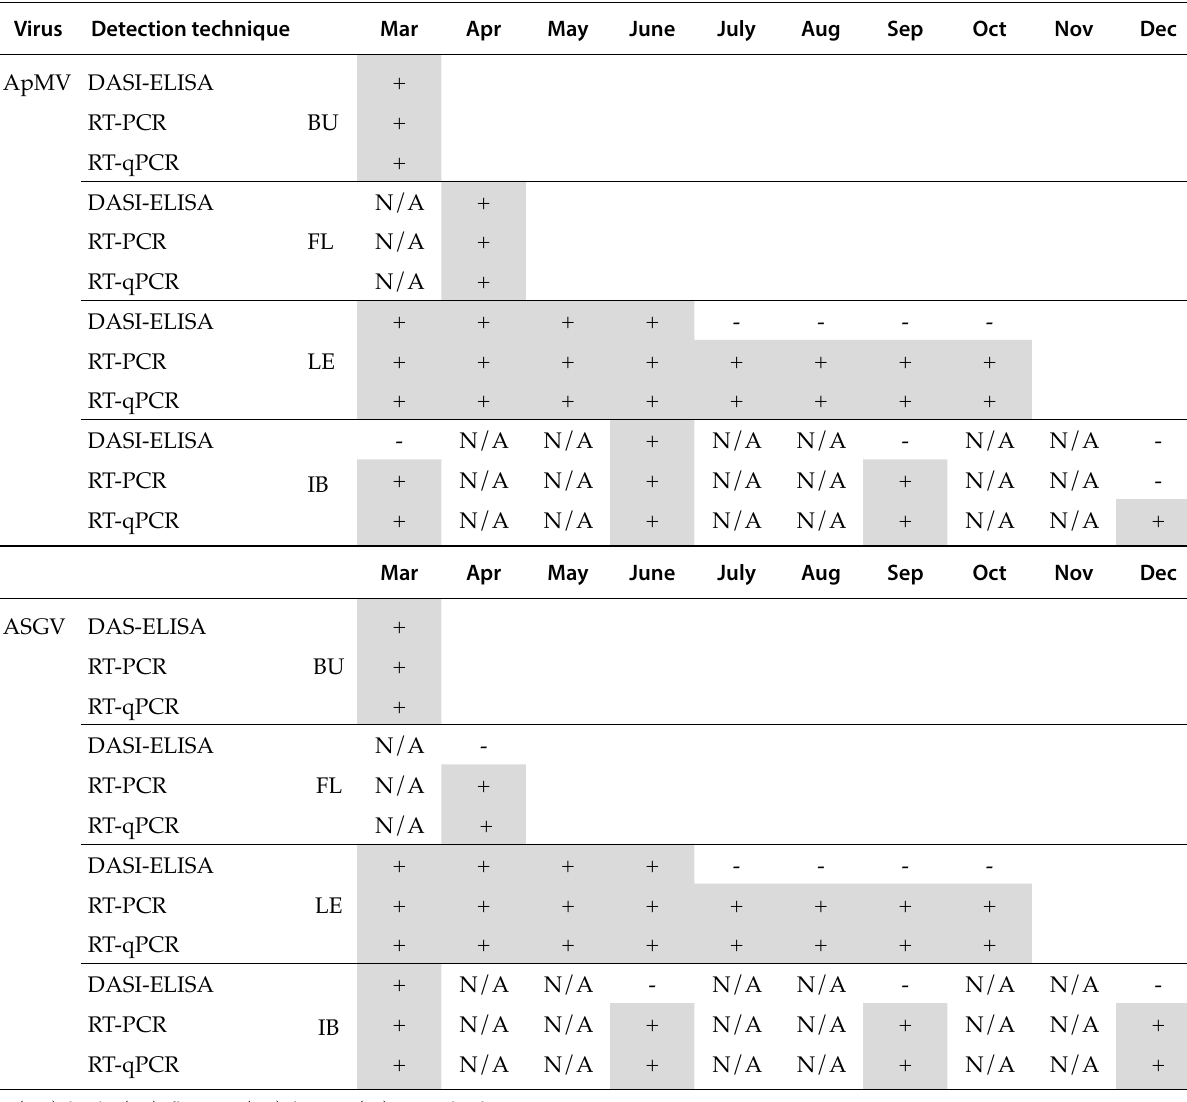
Table 4. Comparison between the reliability of DAS/DASI ELISA, RT-PCR and RT-qPCR for the detection of Apple mosaic virus and Apple stem grooving virus in different plant tissues in different months of 2015.